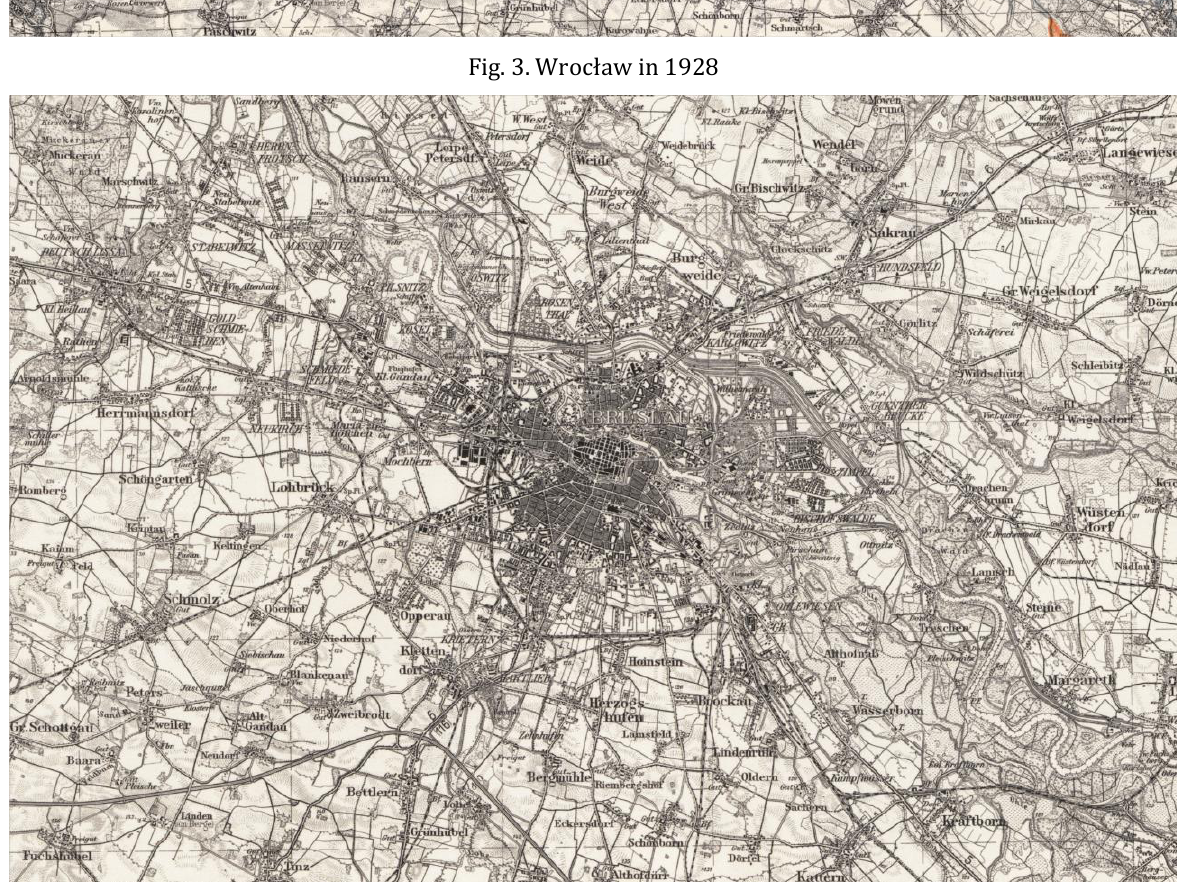
Fig. 3. Wrocław in 1928